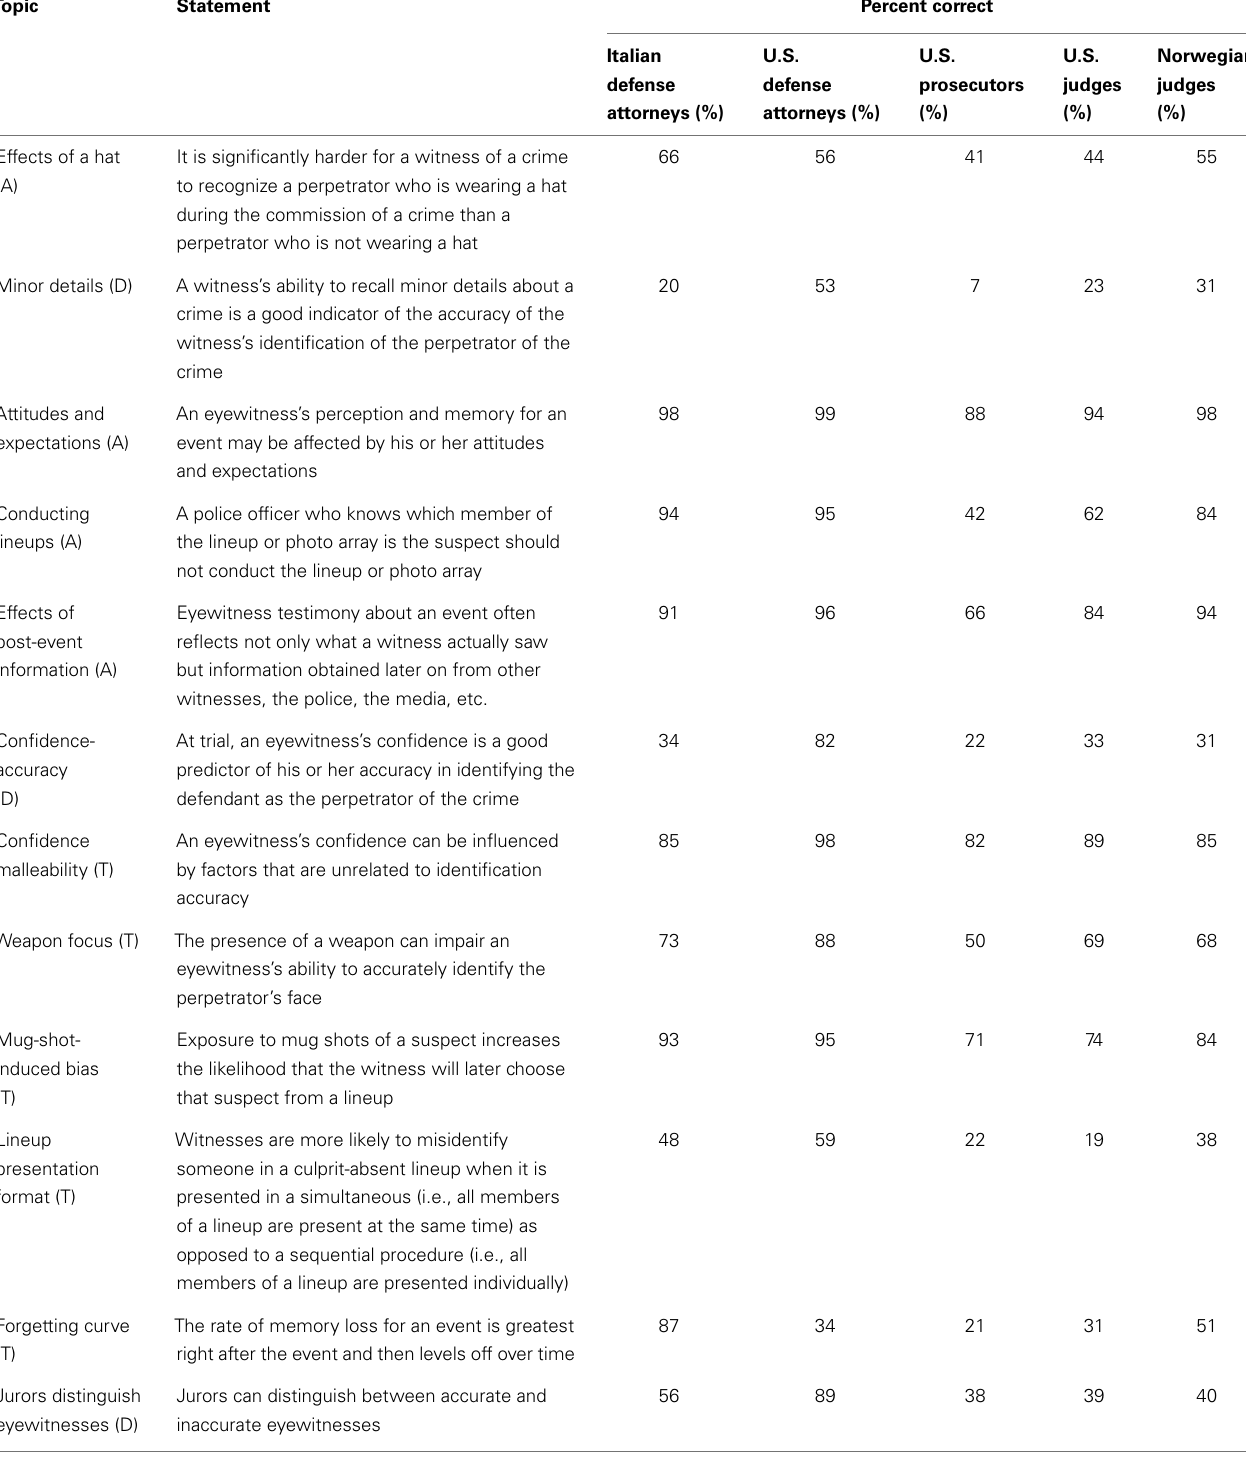
Table 1 | Eyewitness topics and statements and the percentage correct (rounded) for various legal